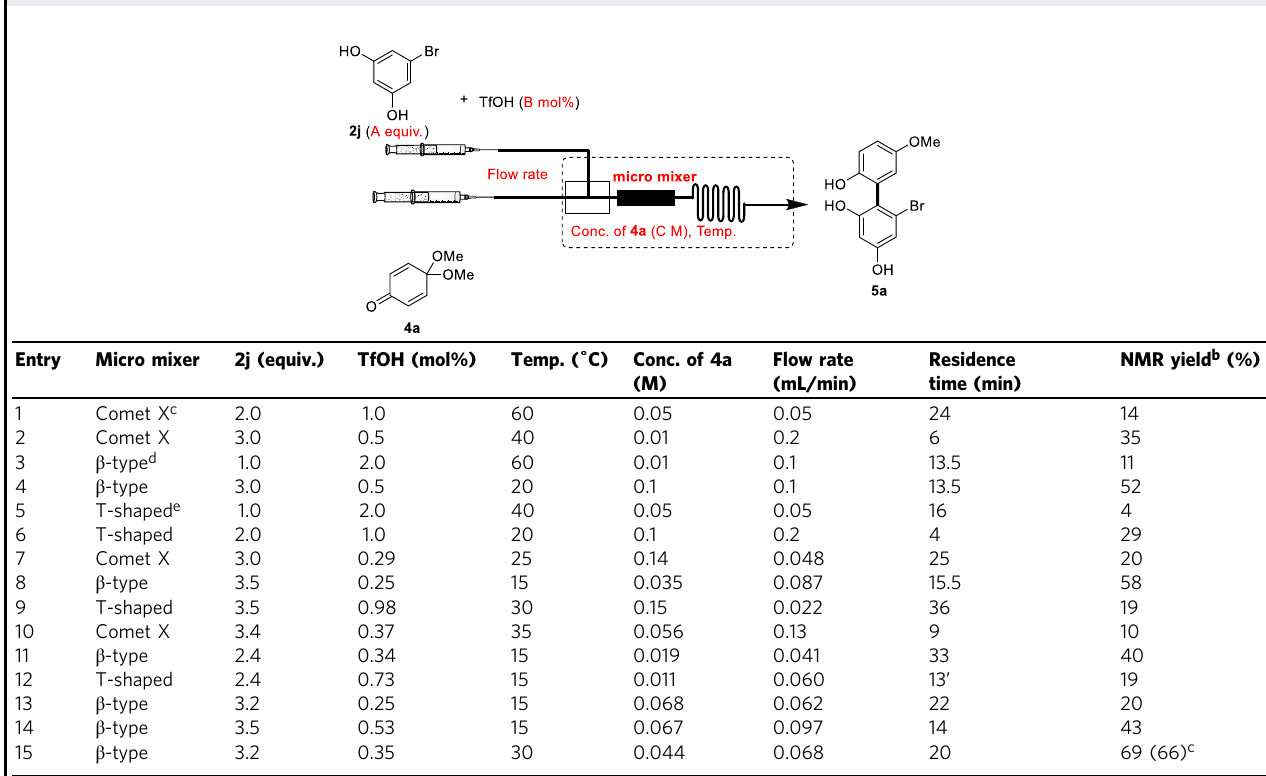
Fig. 3. Using acceptor 4a with 5-methylresorcinol ( 2k ) and non- substituted resorcinol ( 2l ), the corresponding products 5b and 5c , were obtained in moderate yields (59 and 62%,